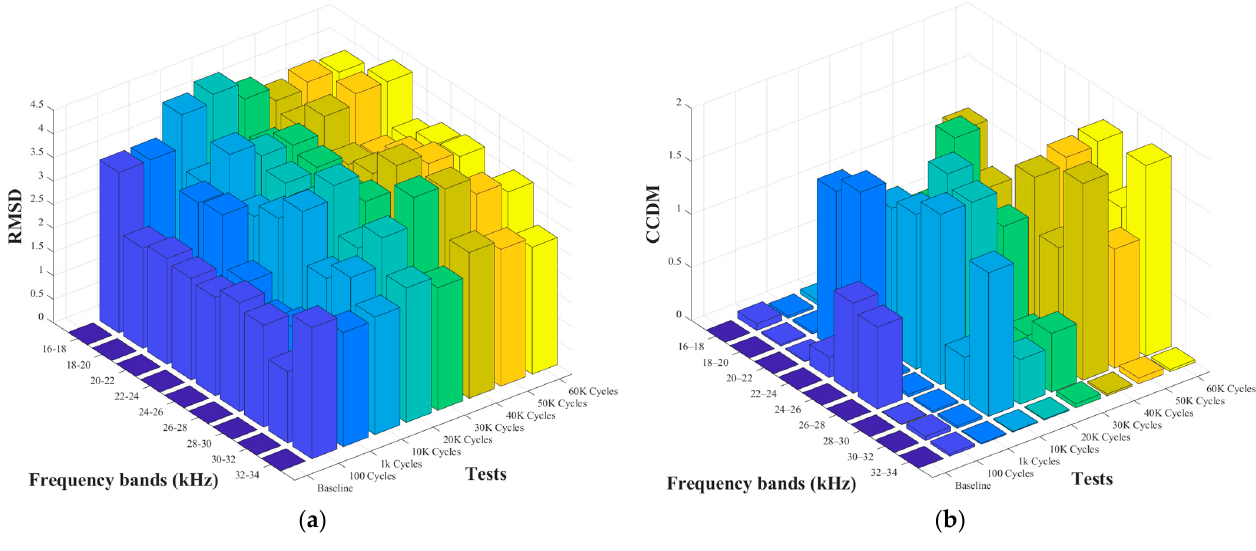
Figure 4. Damage indexes: ( a ) RMSD and ( b ) CCDM index for the 5–8 path with delamination. Using the same parameters, the indices were calculated for the trajectory with fissures.